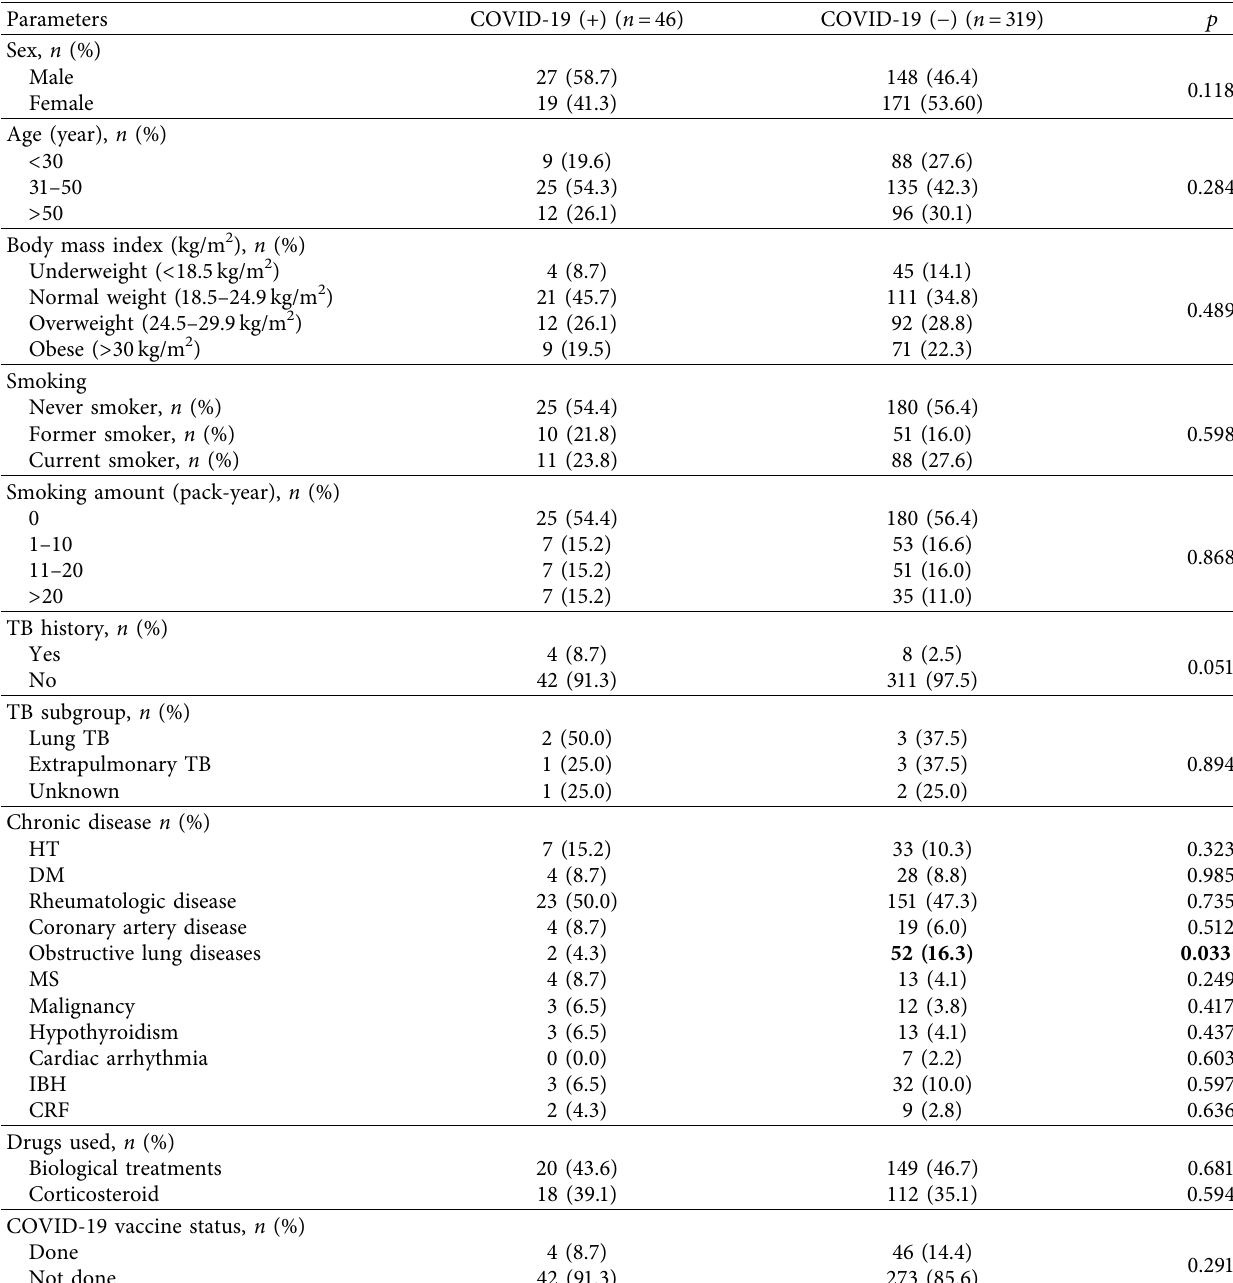
Table 4: Comparison of groups with and without